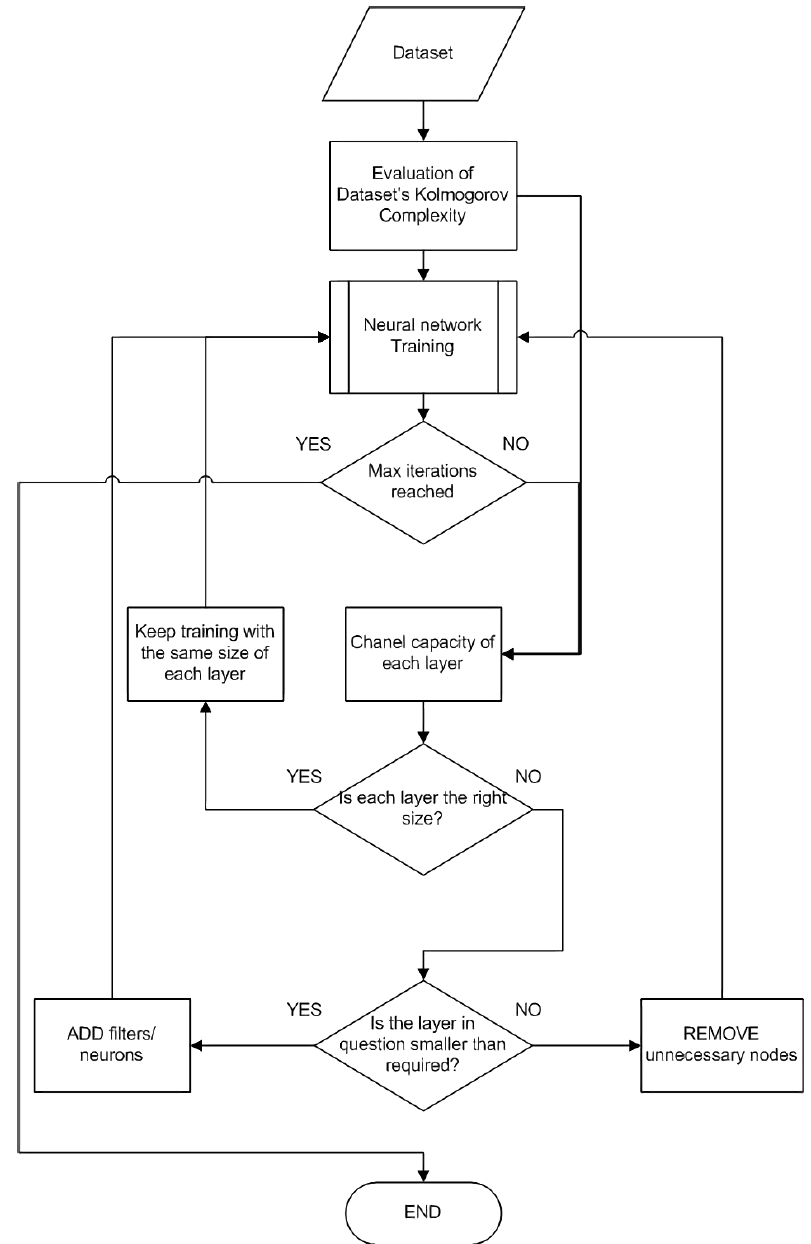
Figure 1. Outline of the proposed